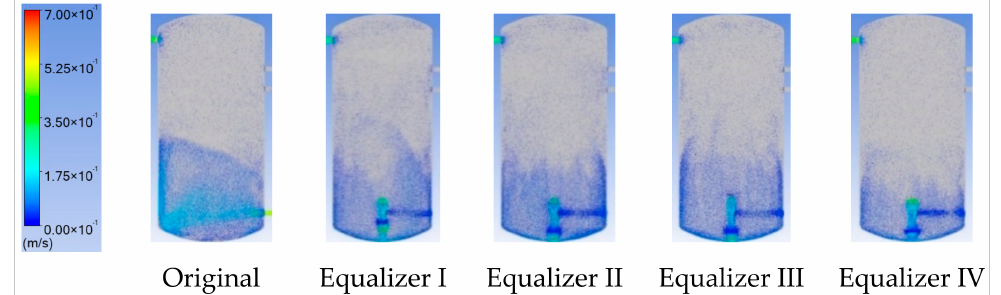
Figure 16. The velocity profiles of the equalizer